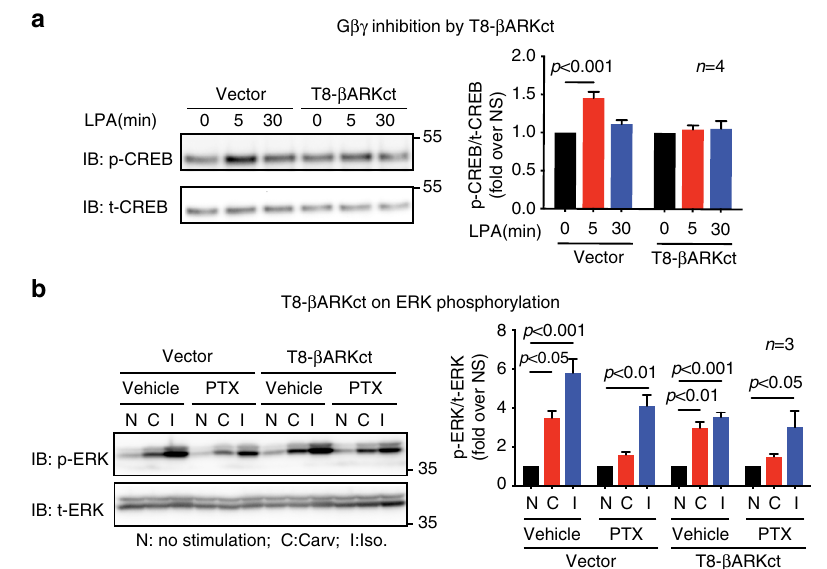
Fig. 7 G βγ subunits are not required for carvedilol-induced β 1 AR-mediated ERK phosphorylation. a Validation of the G βγ inhibition by T8- β ARKct. HEK293 cells with or without transient transfection of T8- β ARKct were stimulated with 10 μ M LPA for 5 min. T8- β ARKct diminished the LPA-induced CREB phosphorylation, a known G βγ -dependent process, con fi rming the inhibition of G βγ subunits by T8- β ARKct. b The G βγ subunits are not required for carvedilol-induced β 1 AR-mediated ERK phosphorylation. β 1 AR stable cells with or without T8- β ARKct transfection was pretreated with vehicle or 200 ng per ml PTX for 16 h. The cells were then stimulated with 10 μ M carvedilol or 10 μ M isoproterenol for 5 min. T8- β ARKct did not have signi fi cant effect on ERK phosphorylation, suggesting that G βγ subunits were not required. Data represent the mean ± SEM for n independent experiments as marked on the fi gure. Statistical signi fi cance vs. unstimulated cells was assessed using one-way ANOVA with Bonferroni